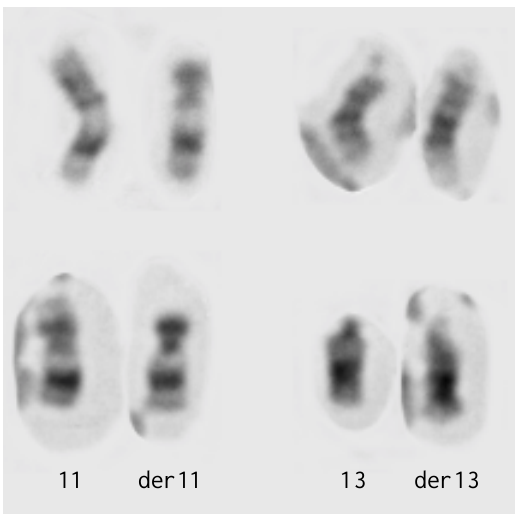
Figure 2 - Proband’s G-banded partial metaphases showing balanced 46,XX,t(11;13)(p13;q33) de novo